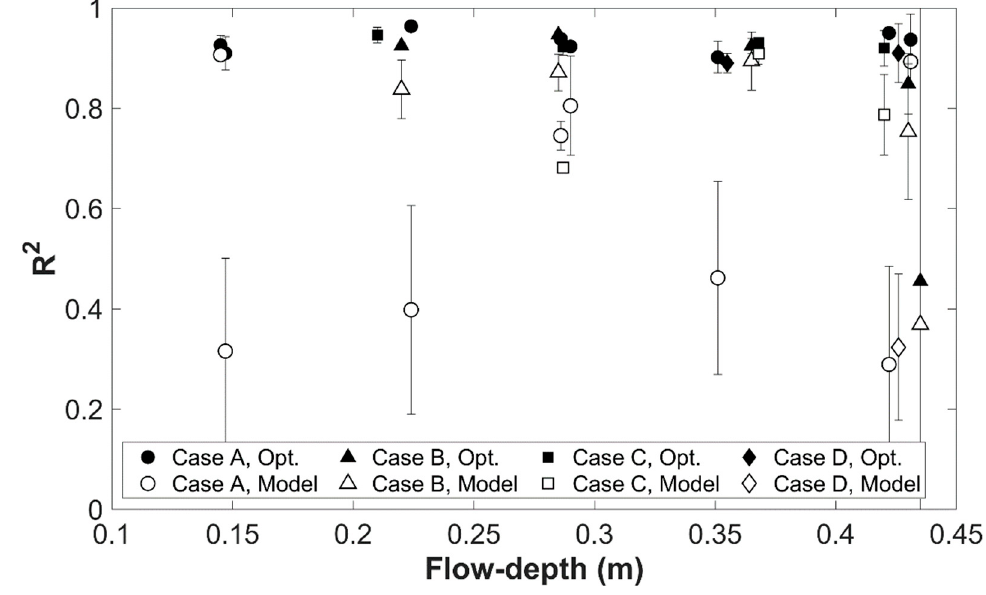
Figure 12. Correlation values R 2 for comparisons between experimental data and down-stream profile prediction for both the model and the model with t and D xx optimized to give best possible fit to data (Opt.). Note, two tests have R 2 < 0 (Case C, level 2, mean R 2 = − 0.67 and Case D, level 4 mean R 2 = − 0.79). These tests are not plotted to allow for a focused view of the majority of the data set.